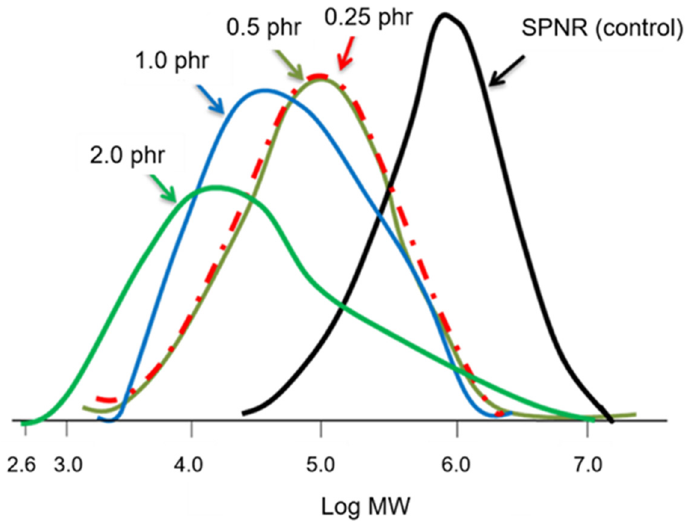
Figure 4. MWD of SPNR latex samples using H 2 O 2 20% w / w with various TiO 2 powder contents under UVC-irradiation for 5 h.